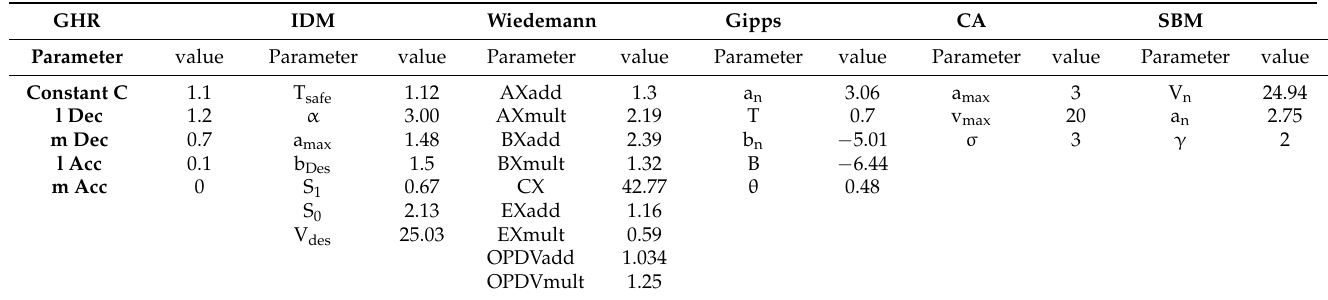
Table 2. Calibrated Parameter Values for Various